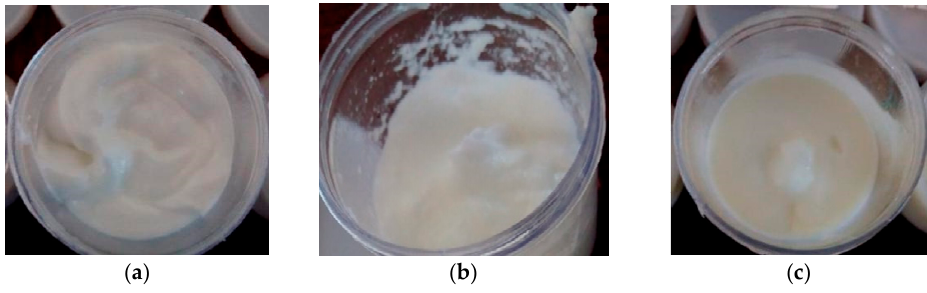
Figure 2. vs ( a ), ow ( b ), and wo ( c ) cream. Table 2. Evaluation of different parameters of cream formulations.